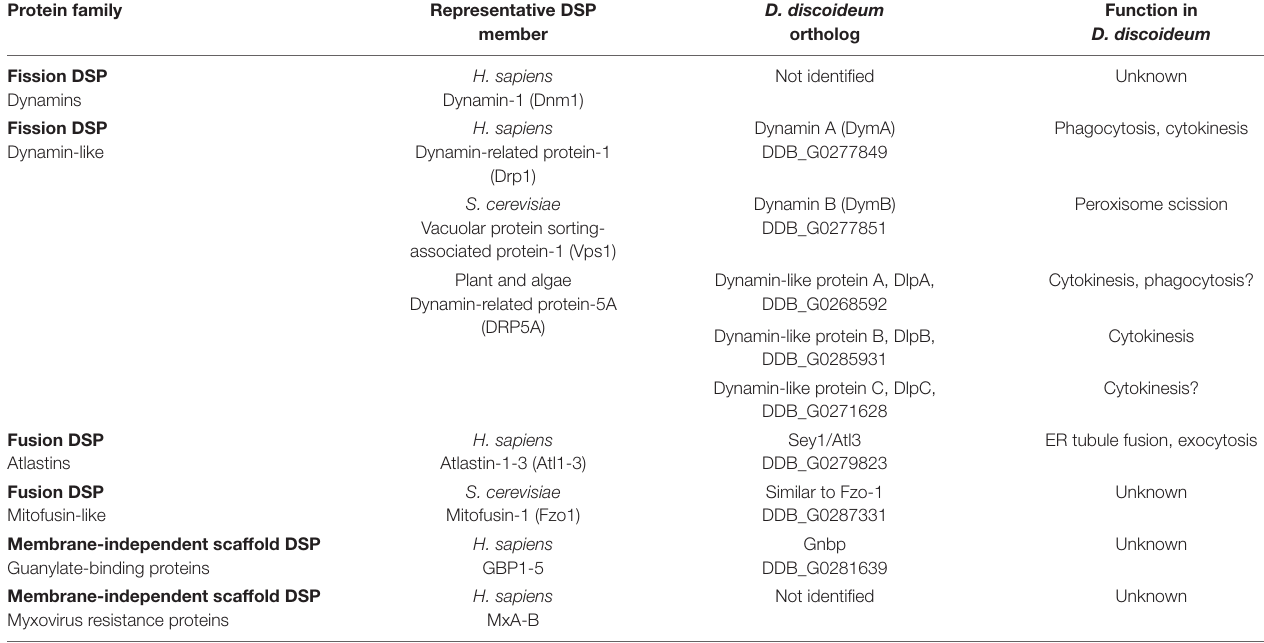
TABLE 1 | Eukaryotic dynamin superfamily proteins. Protein